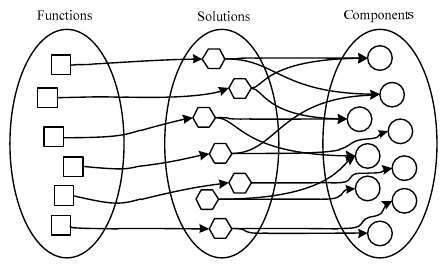
Figure 6. Mapping of functions–solutions–components.